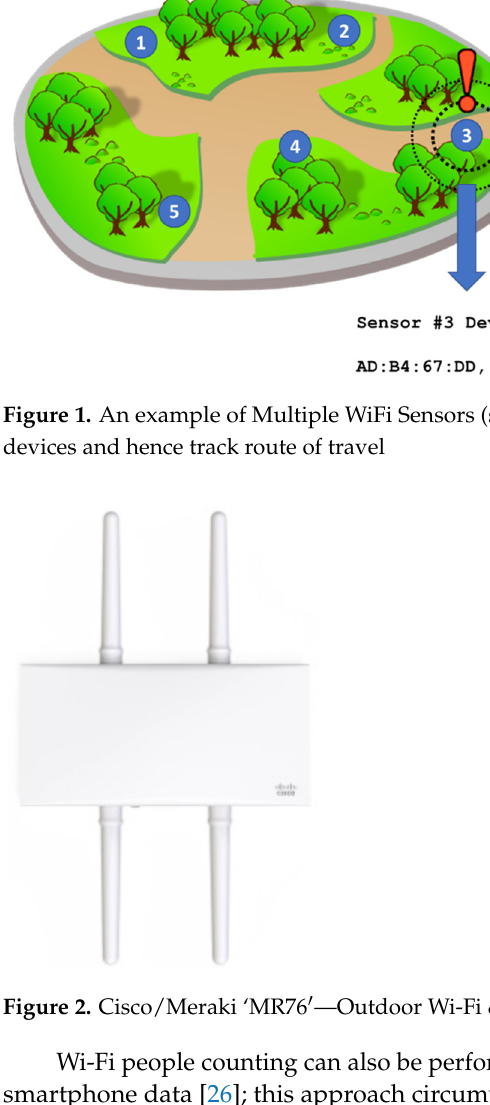
Figure 2. Cisco/Meraki ‘MR76 ′ —Outdoor Wi-Fi & BLE Access Point. Wi-Fi and/or BLE sensors can be placed out of view or mounted at elevation to reduce allows for analysis of returning visitors, and unique or new visitors can be differentiated.